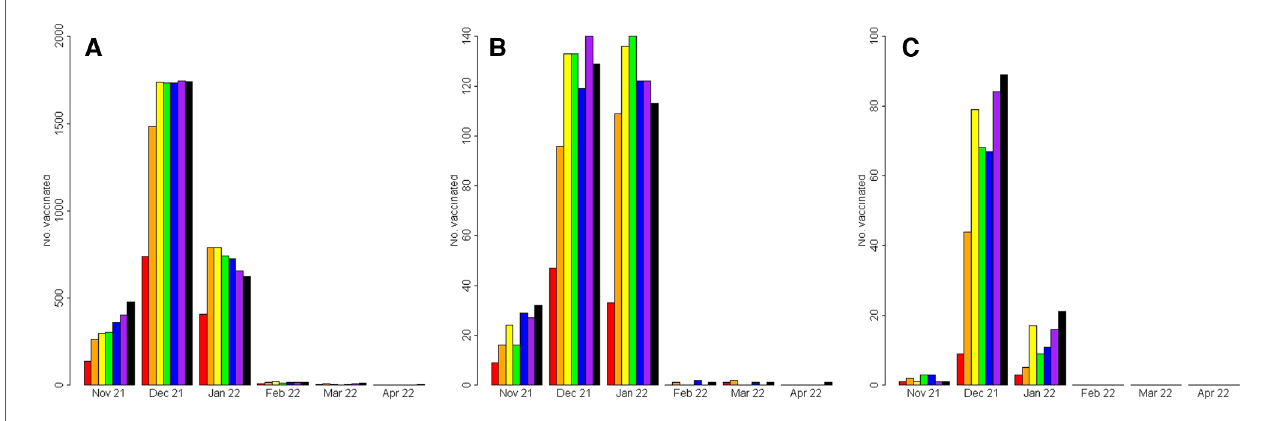
FIGURE 1 Timing of vaccination by sector and age. ( A ) Non-ultraorthodox Jewish children ( B ) Ultra-orthodox Jewish children ( C ) Arab children. Red- children aged 5 years; Orange- children aged 6 years Yellow- children aged 7 years; Green- children aged 8 years Blue- children aged 9 years; Violet- children aged 10 years Black- children aged 11 years.